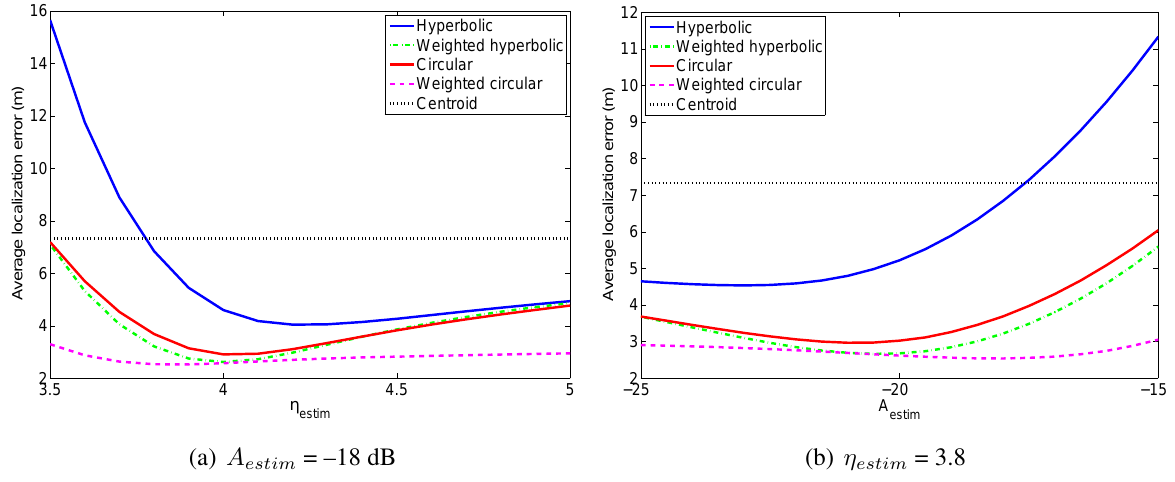
Figure 10. Average localization error in the WiFi experiment for different values of η and A . estim